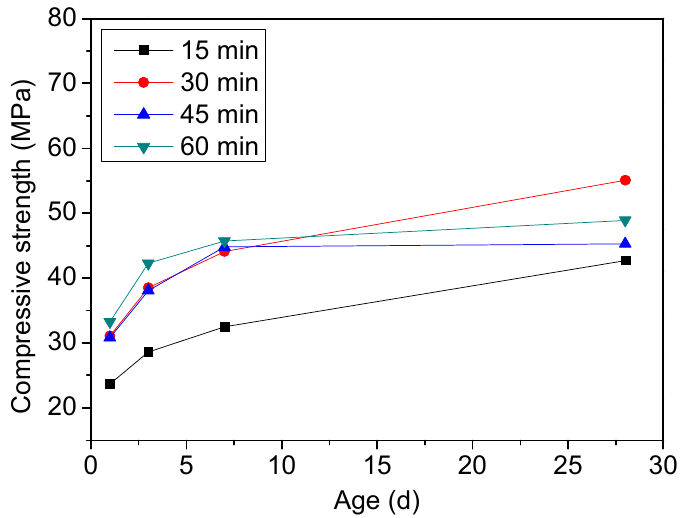
Figure 7. Compressive strength of cement clinker B sintered at 1150 °C for different retention times.